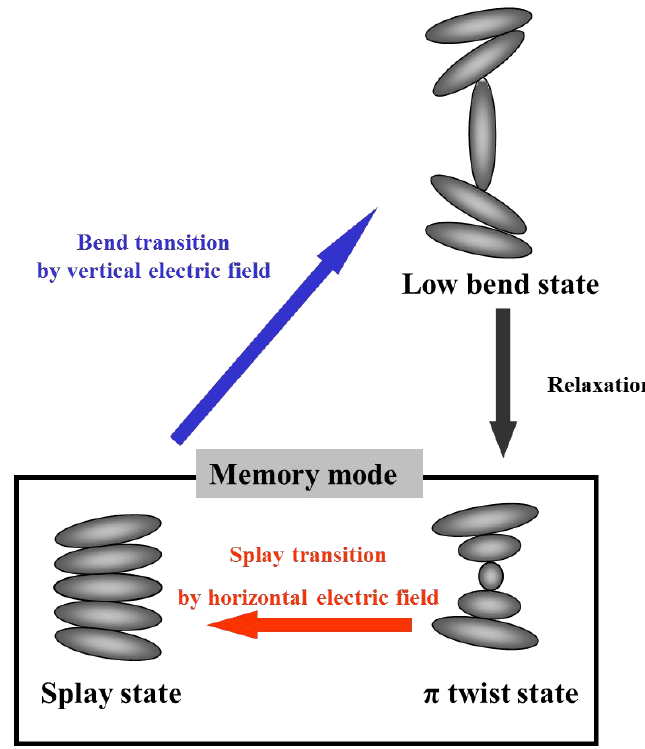
Figure 1. Phase transition of bistable chiral splay nematic (BCSN) mode. When the vertical electric field is applied to the splay state, it is switched to the bend state represented by the blue arrow. As the applied field is removed, the bend state is relaxed into the π twist state represented by the black arrow. By the horizontal electric field, the π twist state is switched into the splay state represented by the red arrow.